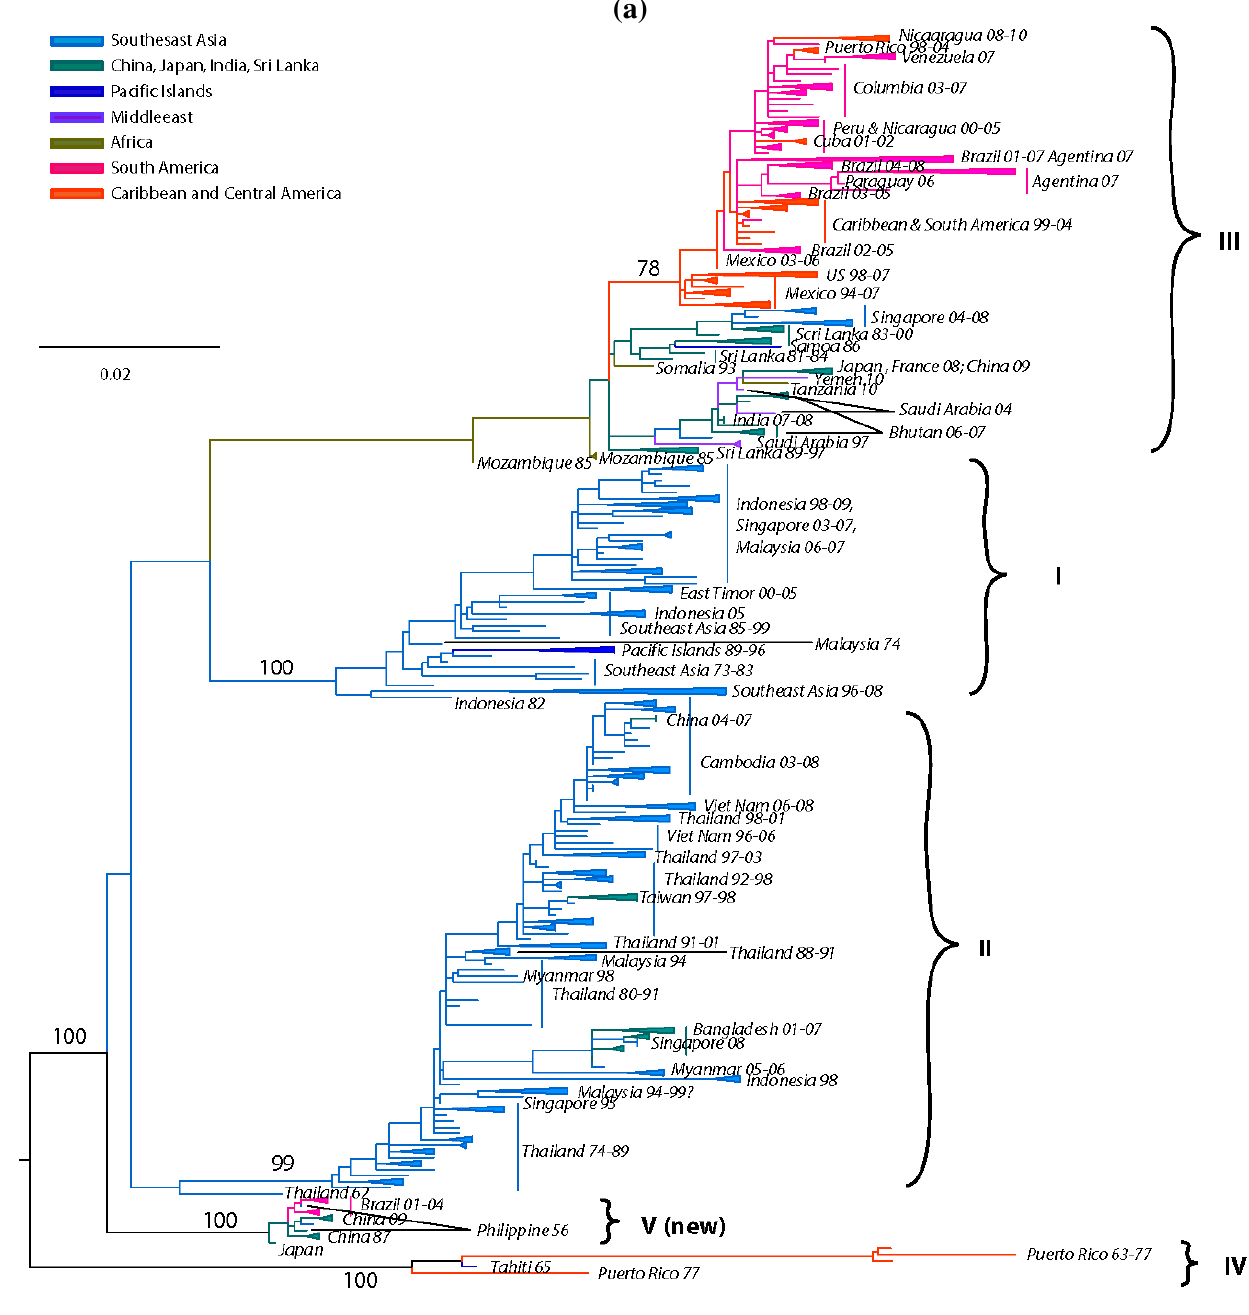
Figure 4. ( a ) Dengue Virus Type 3 Phylogeny. Maximum Likelihood Tree (MLT) of DENV-3 based on complete E gene nucleotide sequences of all available naturally occurring strains (n = 1208) from GenBank. MLT was reconstructed using PAUP* version 4b10-MacOsX package [161], employing the NNI branch swapping method, and based on the best-fit nucleotide substitution model estimated by MODELTEST [162]. Bootstrap values (NJ method with 1000 replications) above 70 were labeled along the branch of major clades. The tree is mid-point rooted. Color lines represent specific geographic regions as specified within figure. ( b ) Genotype V lineage